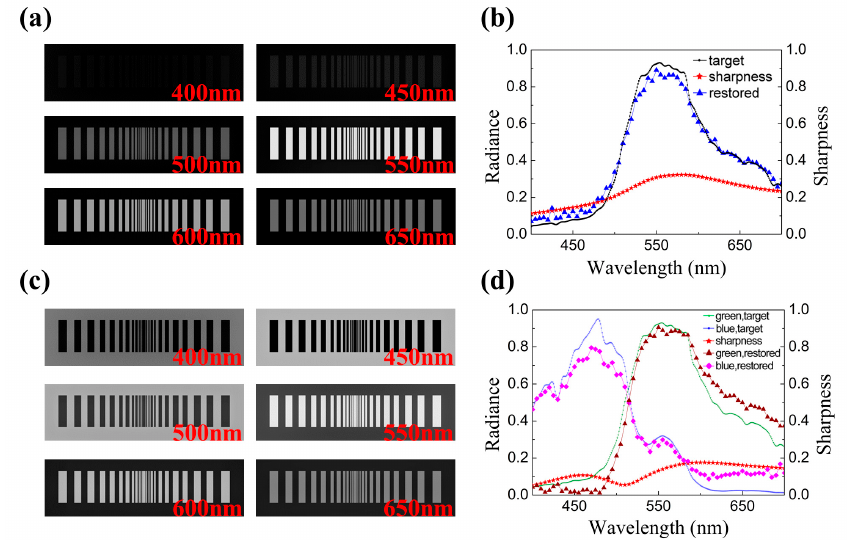
Figure 5. Spectral image restoration and spectral discrimination of two striped targets. ( a , c ) Restored images of green stripes with a black background target and green stripes with a blue background target, respectively, at different wavelength bands. ( b , d ) We plot the restored spectral curve by averaging the pixel values (3 × 3 pixels) of the ROI of green stripes or blue background in each restored image frame. The sharpness curve is calculated from each frame of the blurred image of the target.